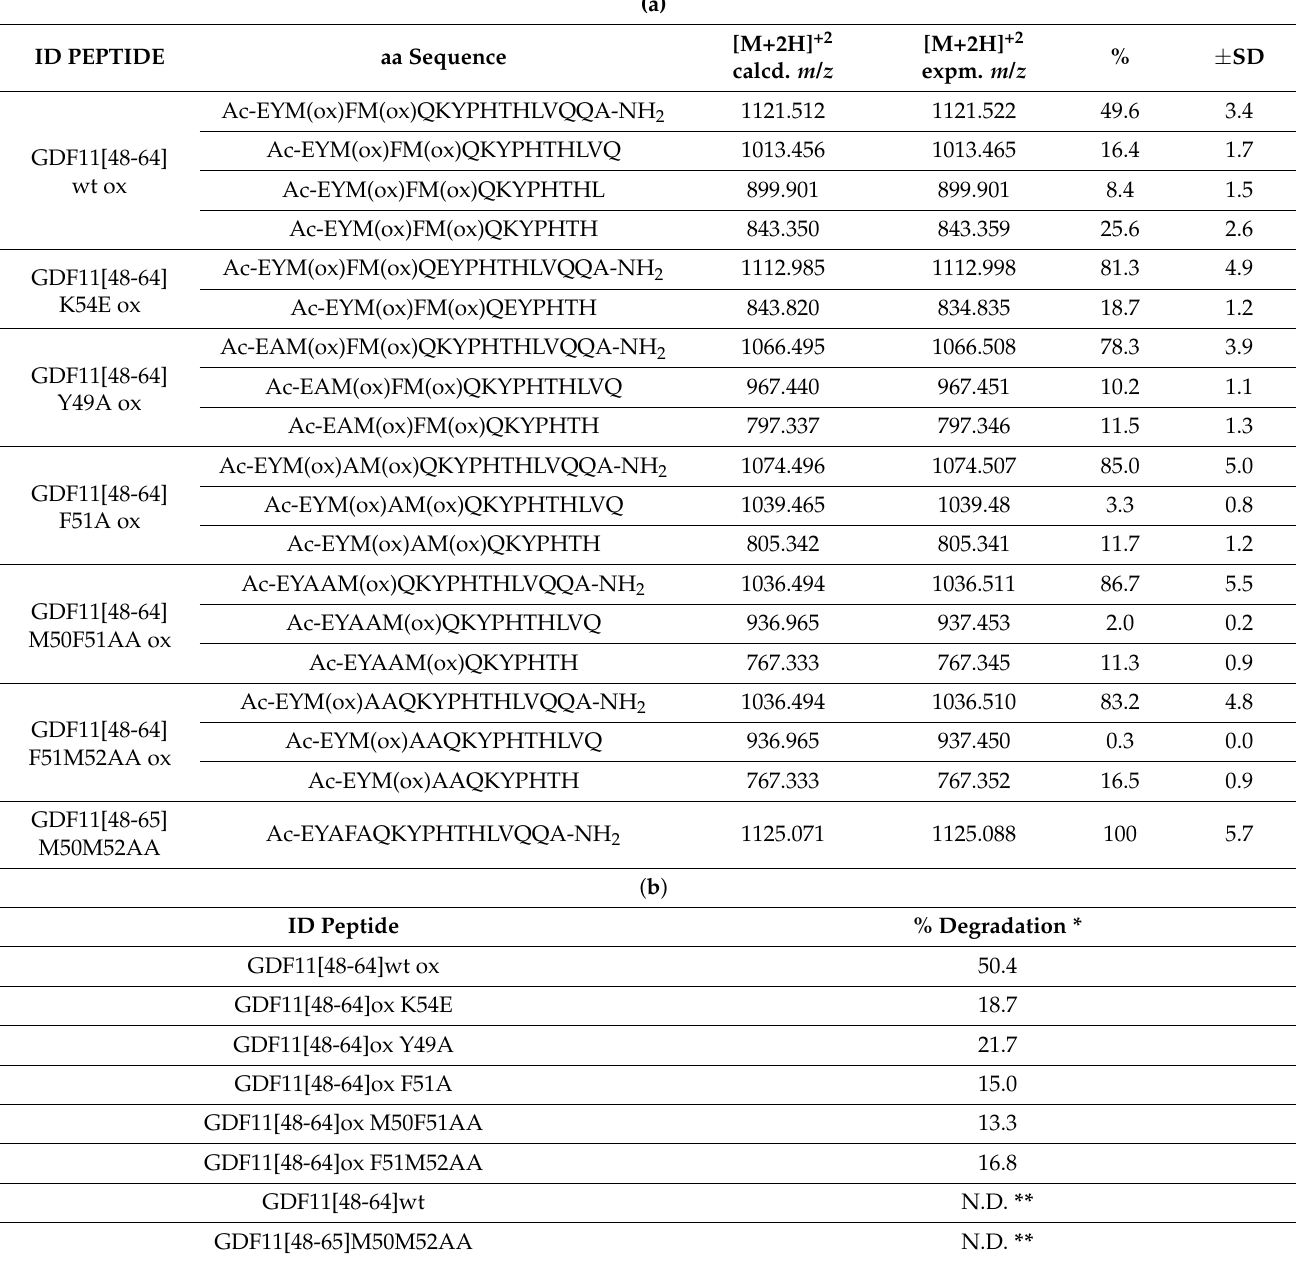
Table 2. ( a ): GDF11-related peptides containing Met(O) residues used as substrate models to evaluate the APEH endoprotease activity. The fragments observed following APEH exposure are reported, together with sequences and amount of fragments generated calculated as percentage of the initial substrate. The experimental and calculated MWs (doubly charged ions) are also reported. Data are reported as the average of three independent experiments. SD, standard deviation. ( b ): Overall % of oxidized GDF11 peptides degraded upon exposure to